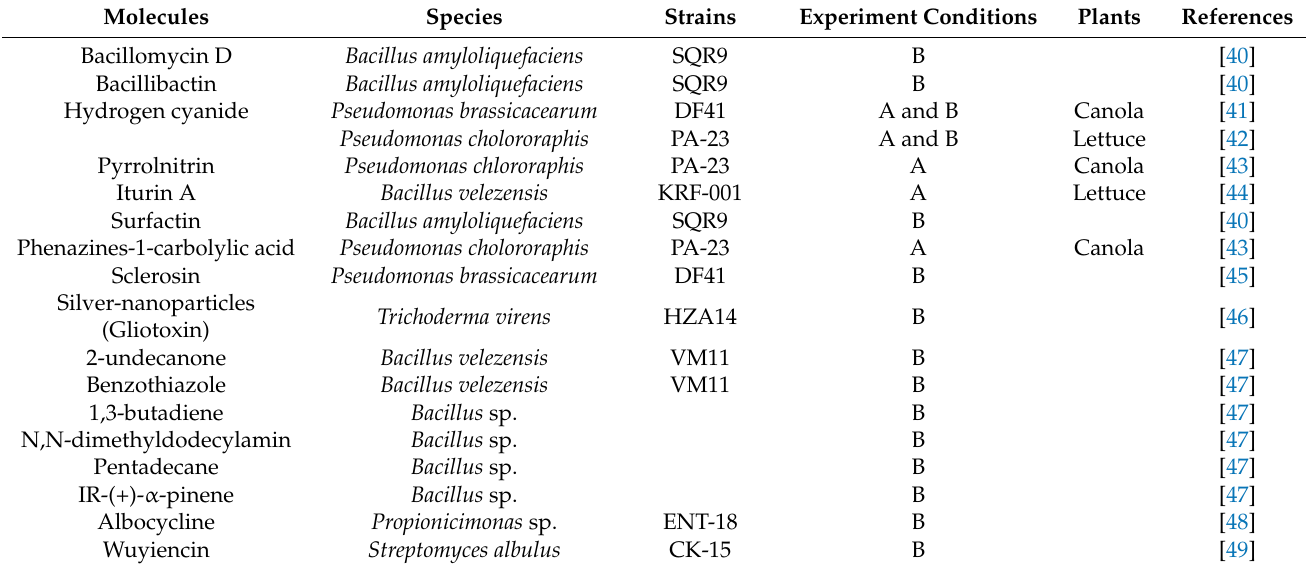
Table 1. Antimicrobial molecules inhibiting S. sclerotiorum through